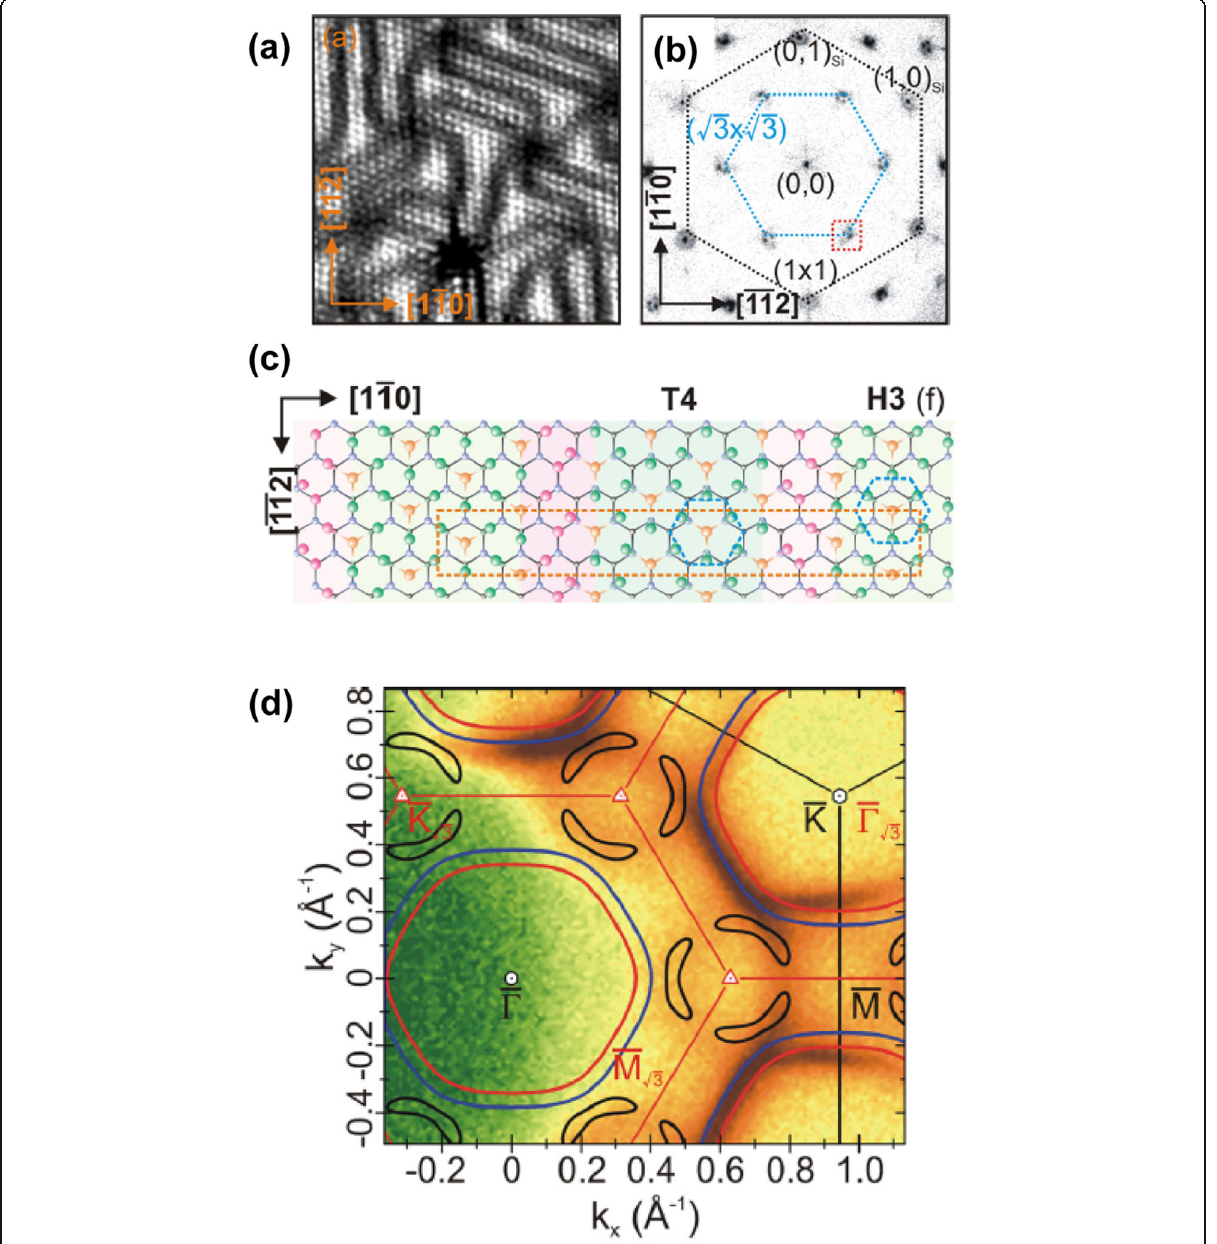
Fig. 6 Crystalline and electronic structures of Si(111)-SIC-Pb. a Large-scale STM image (20 nm × 20 nm). b High-resolution LEED pattern with E = 80 eV. c Schematic structure model for a superstructure with ( √ 3 × √ 3) reconstructions in H 3 and T 4 geometries. d Constant-energy contours taken through ARPES 178 meV below E F and those deduced from a modeling (red and blue lines). Reprinted figure with permission from C. Brand et al. Phys. Rev. B 96 , 035432 (2017) [86]. Copyright 2017 by the American Physical Society.